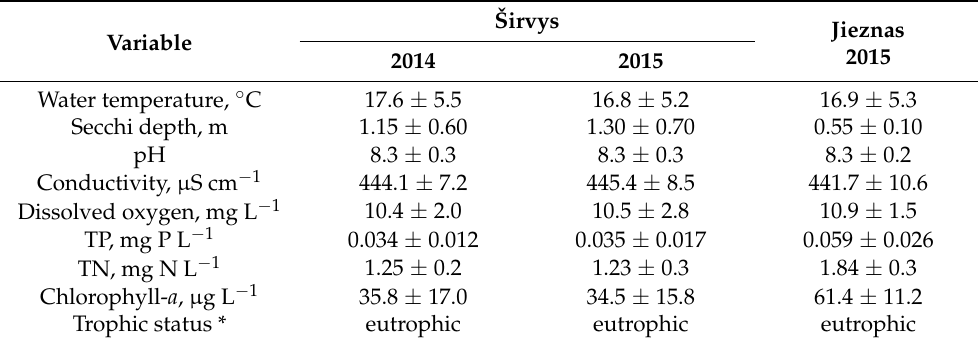
Table 2. Physicochemical, biological variables and trophic status of the lakes Širvys and Jieznas during the study period. The data are presented as average ±